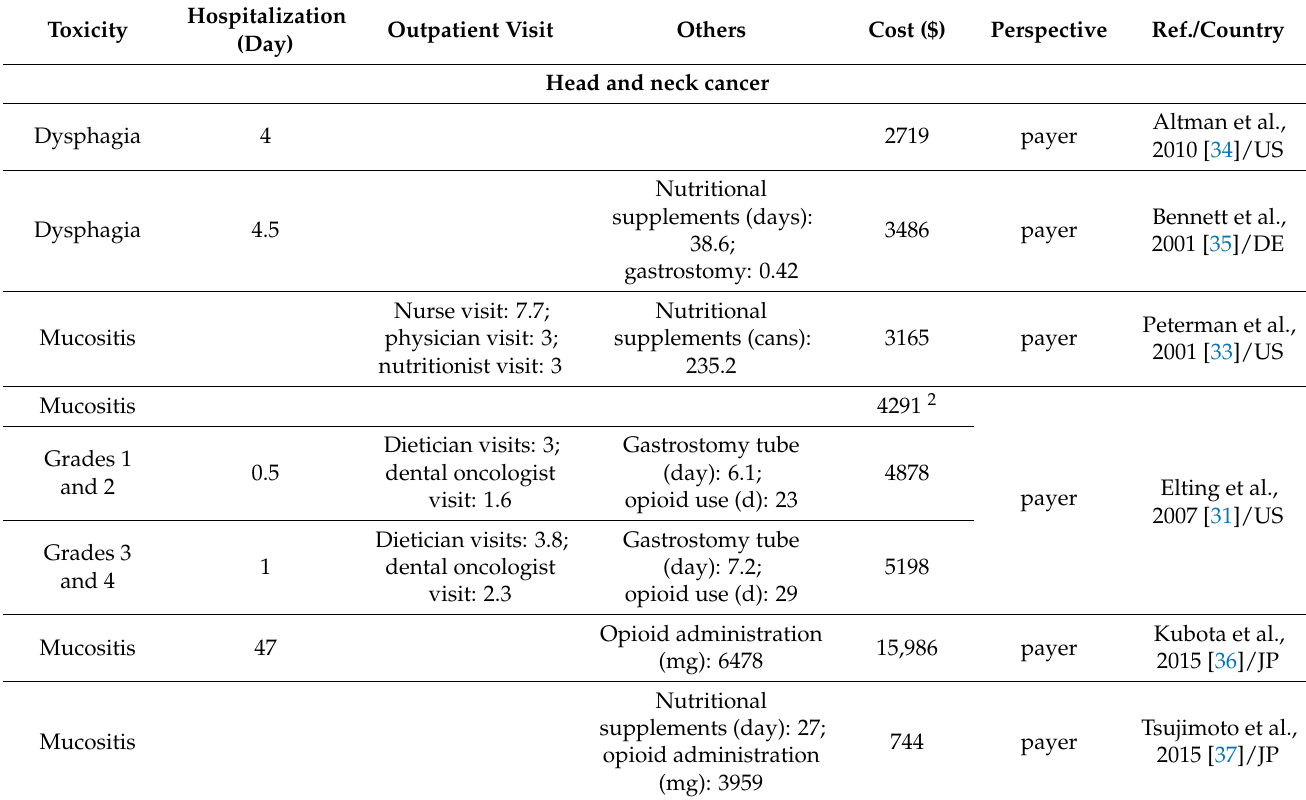
Table 3. Reported healthcare resource use converted into monetary value 1